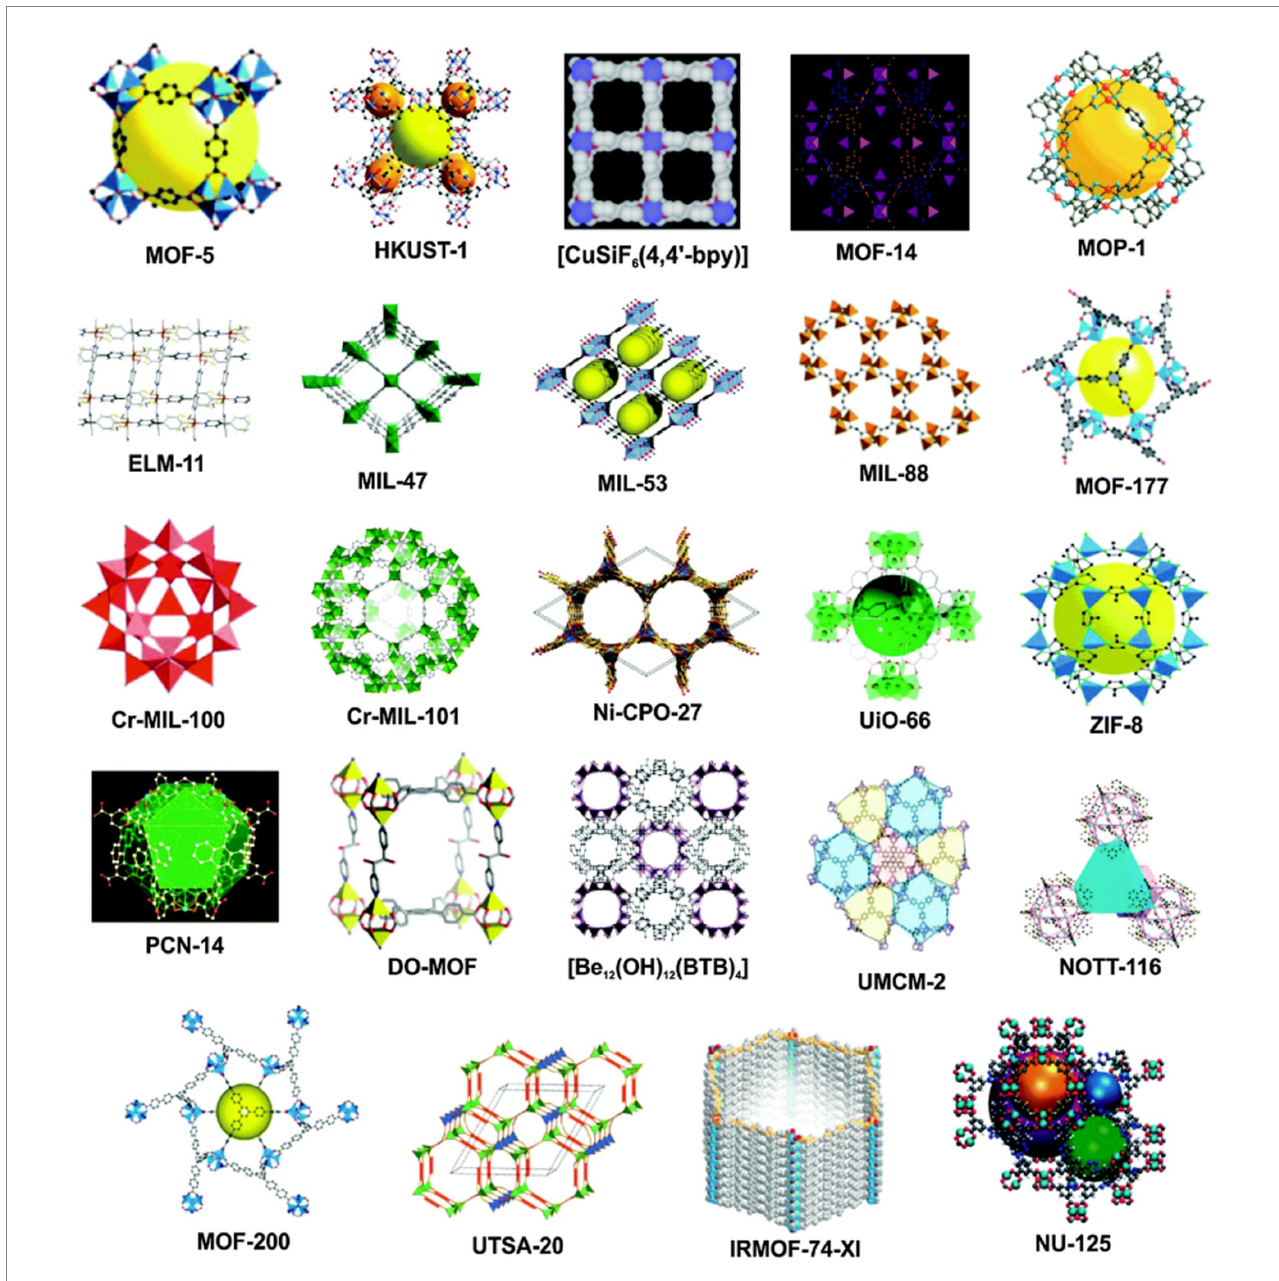
FIGURE 3 Typical examples of different types of porous MOFs structures